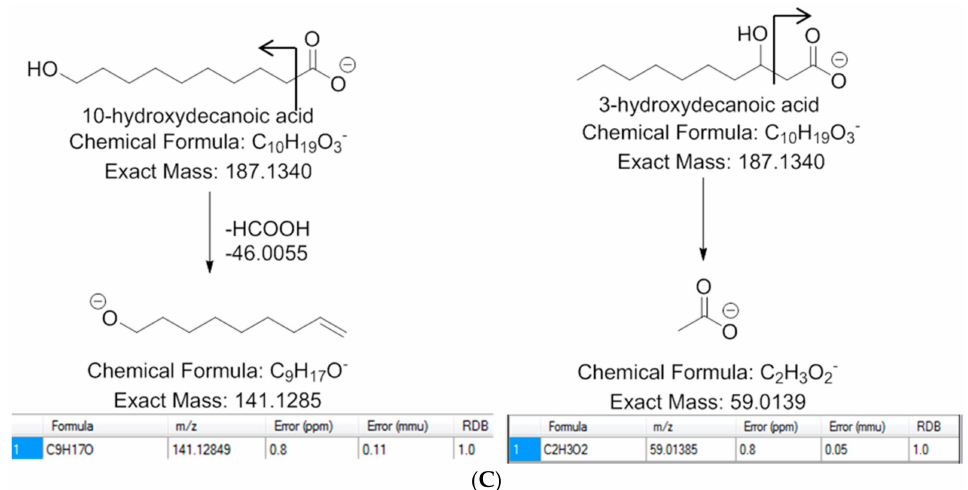
Figure 1. MS / MS spectra of ( A ) 10-hydroxydecanoic acid; ( B ) 3-hydroxydecanoic acid; and ( C ) proposed fragmentation pathways in negative ESI mode.